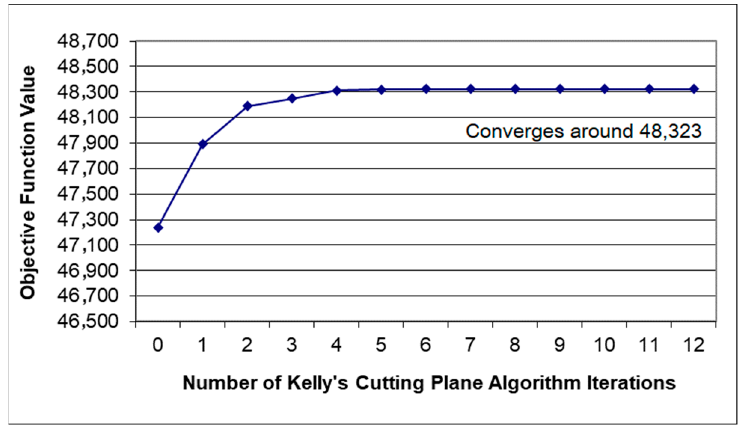
Figure 6. Outer approximation.